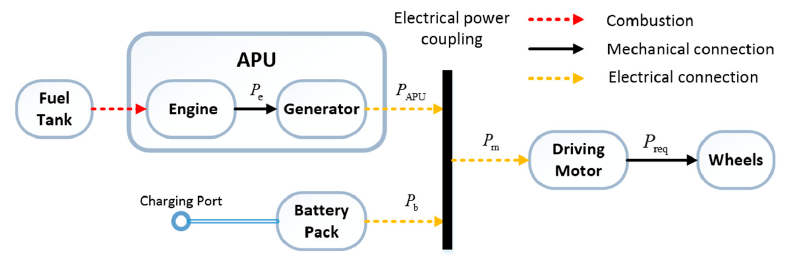
Figure 1. Extended-range electric bus powertrain. Table 1. Main component parameters of E-REB.